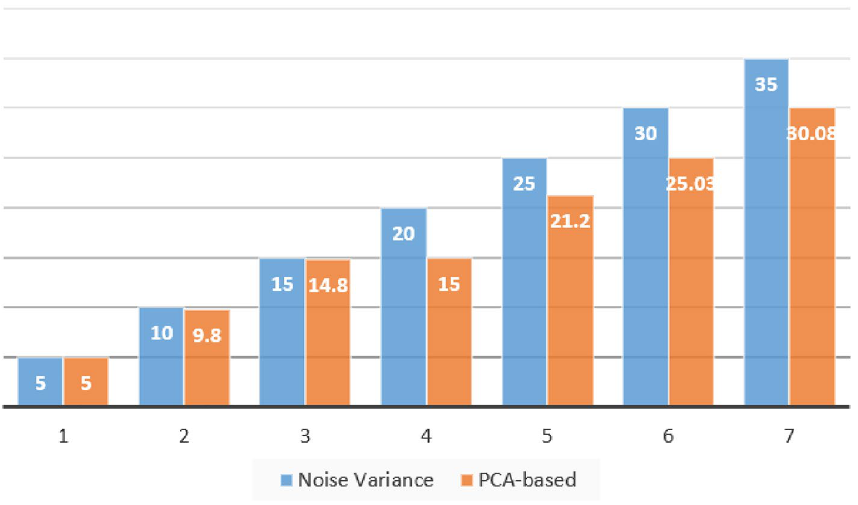
Figure 1. The PCA-based noise variance estimation. Added noise variance on the left, PCA-based estimates on the right.